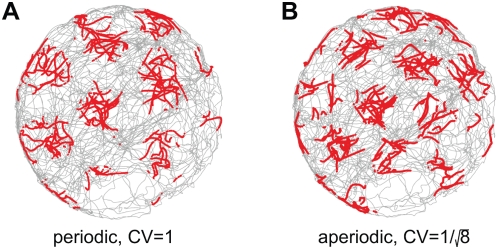
Single neuron (SN) responses from stochastic spiking networks.(A) SN response in a stochastic spiking periodic network. The parameters
and input velocity trajectory are as in Figure 2A–C, except that
spiking is simulated explicitly and the spikes are generated by an
inhomogeneous Poisson process. (B) SN response in a stochastic spiking
aperiodic network. The parameters are as in Figure 2D–F, except that
spiking is simulated explicitly and the spikes are generated by a point
process with a CV of  (see
Methods
). Each red dot represents a spike.